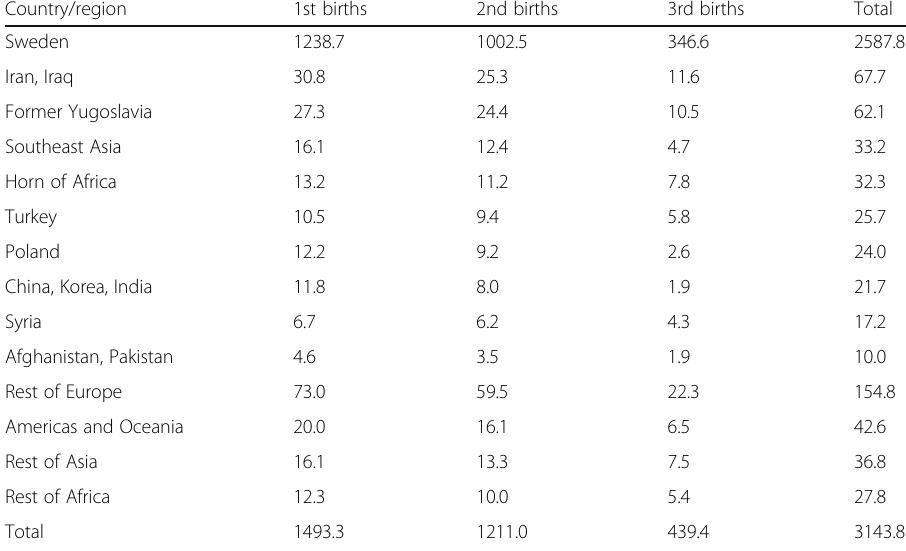
Table 1 Number of births, by birth order, and country/region of birth of the mother, in thousands: Sweden, 1980 – 2015